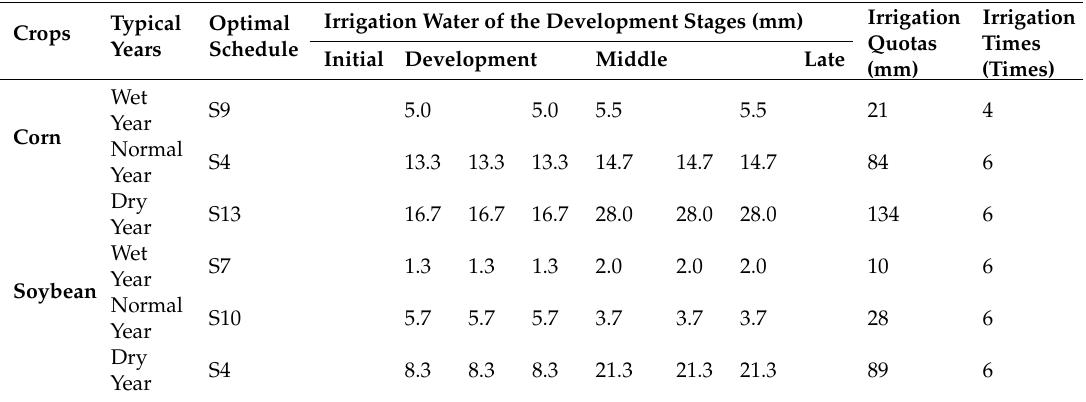
Table 5. Crop optimal irrigation